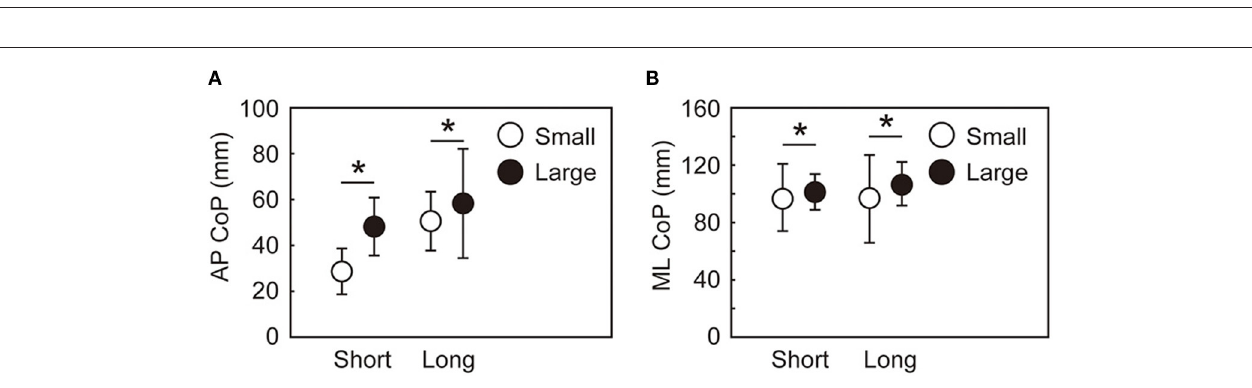
M-L CoP displacement [A-P: F (1, 15) 0.12; M-L: F (1, 15)